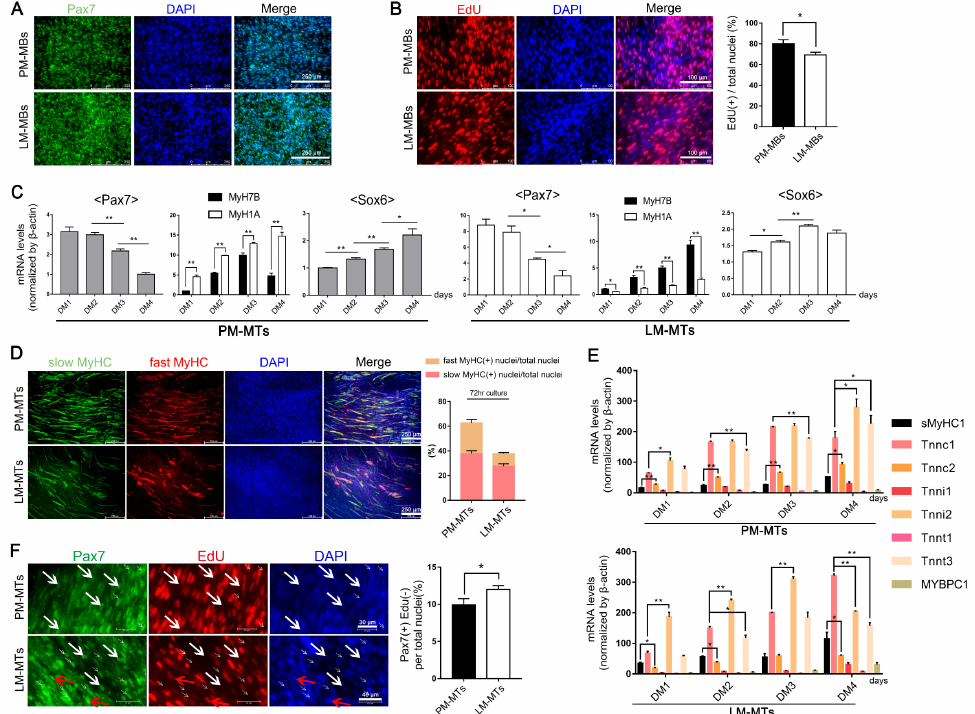
Figure 1. Differences in the myogenic capacity of the satellite cells from fast- and slow-type muscles. ( A ) Freshly isolated satellite cells from PM and LM were stained with satellite cell marker Pax7 (green) and DAPI (blue). ( B ) Satellite cells isolated from PM and LM were cultured in the growth medium with EdU for 6 h. The proliferating cells were stained with Edu (red) and nuclei were stained with DAPI (blue) (mean ± SEM; * p < 0.05; n = 3; two-tailed Student’s t -test). ( C ) PM-MBs and LM-MBs were cultured in DM for 4 days, the relative expression levels of Pax7 , MyH1A , MyH7B and Sox6 in myotubes in DM in different days were quantified by qPCR (mean ± SEM; * p < 0.05; ** p < 0.01; n = 3; two-tailed Student’s t -test or one-way analysis of variance with Tukey’s multiple comparison test). ( D ) After inducing differentiation for 3 days, myotubes in PM-MTs and LM-MTs were performing double immunofluorescence staining with S58 (slow-type MyHC, green) and F59 (fast-type MyHC, red) and nuclei were stained with DAPI (blue). The slow MyHC(+) nuclei or fast MyHC(+) nuclei were counted and the proportion of slow MyHC(+) cells or fast MyHC(+) cells relative to the total nuclei was quantified (mean ± SEM; n = 3). ( E ) The relative expression levels of the slow-type fiber isoforms sMyHC1 , Tnnc1 , Tnni1 , Tnnt1 , MYBPC1 and the fast-type fiber isoforms Tnnc2 , Tnni2 , Tnnt3 in PM-MTs and LM-MTs in DM in different days were quantified by qPCR (mean ± SEM; * p < 0.05; ** p < 0.01; n = 3; one-way analysis of variance with Tukey’s multiple comparison test). ( F ) PM-MBs and LM-MBs were cultured in DM for 5 days and EdU was added to the culture medium 24 h prior to harvest. In the end, the cells were stained with Pax7 (green) and EdU (red) (mean ± SEM; * p < 0.05; n = 3; two-tailed Student’s t -test). White arrows represent part of the typical Pax7(+)EdU( − ) cells and red arrows represent part of the typical Pax7(+)EdU(+)